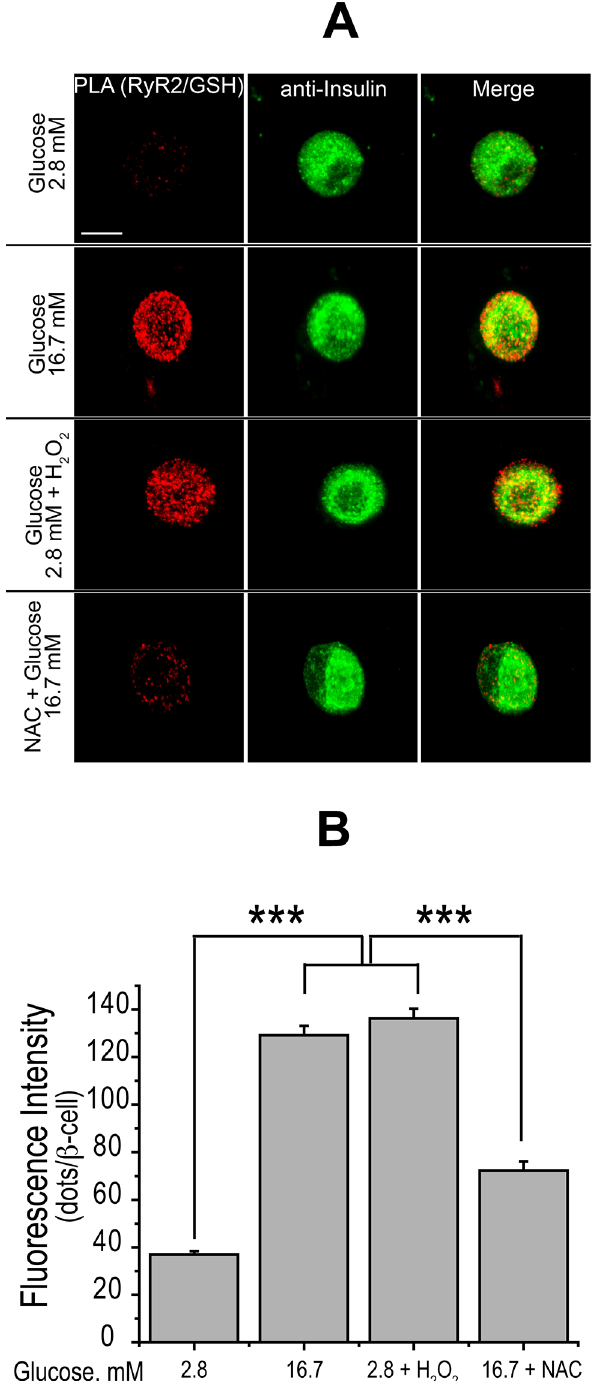
Fig 8. Stimulatory glucose concentrations and H 2 O 2 promote RyR2 S -glutathionylation; NAC inhibits this response. (A) Representative image of β -cells disaggregated from islets showing RyR2 S -glutathionylation with the PLA assay (red fluorescence) and insulin immunostaining (in green). H 2 O 2 : 100 μ M; NAC: 10 mM. Calibration bars = 20 μ m. (B) Quantification of the effects illustrated in A (Mean ± SEM, N = 3). Statistical significance was determined with one-way ANOVA followed by Tukey multiple comparison test. *** : p <